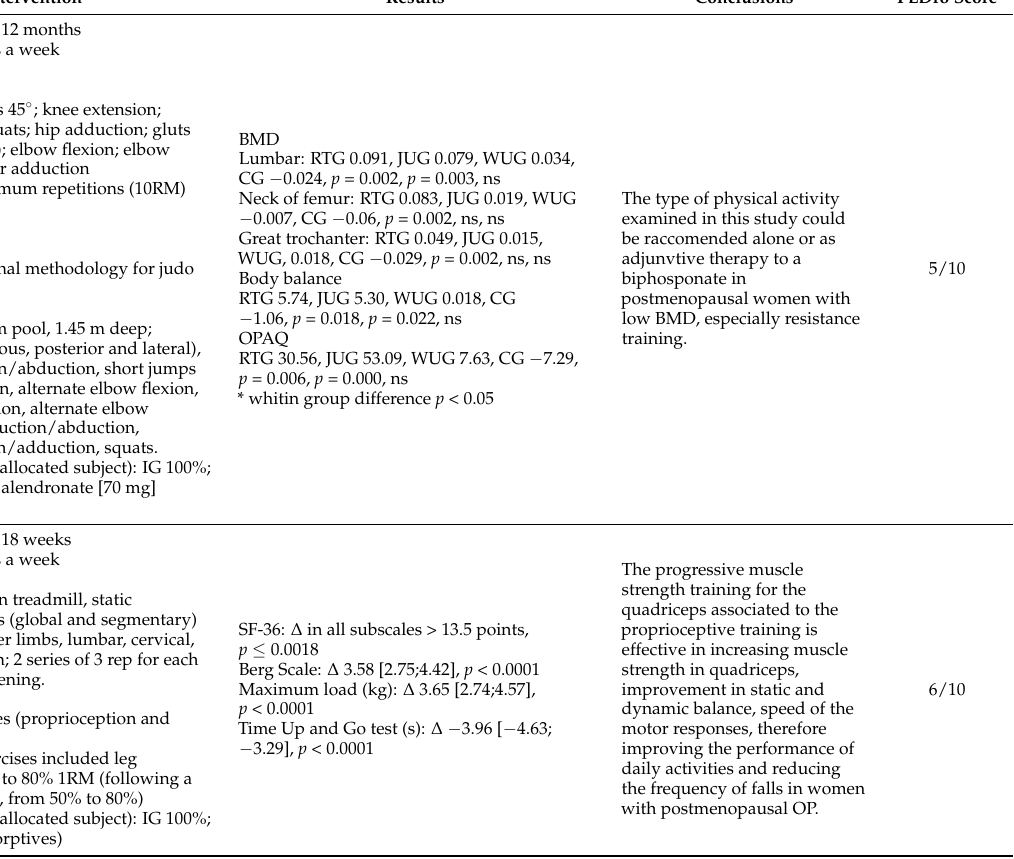
Protocol duration: 18 weeks Frequency: 2 times a week